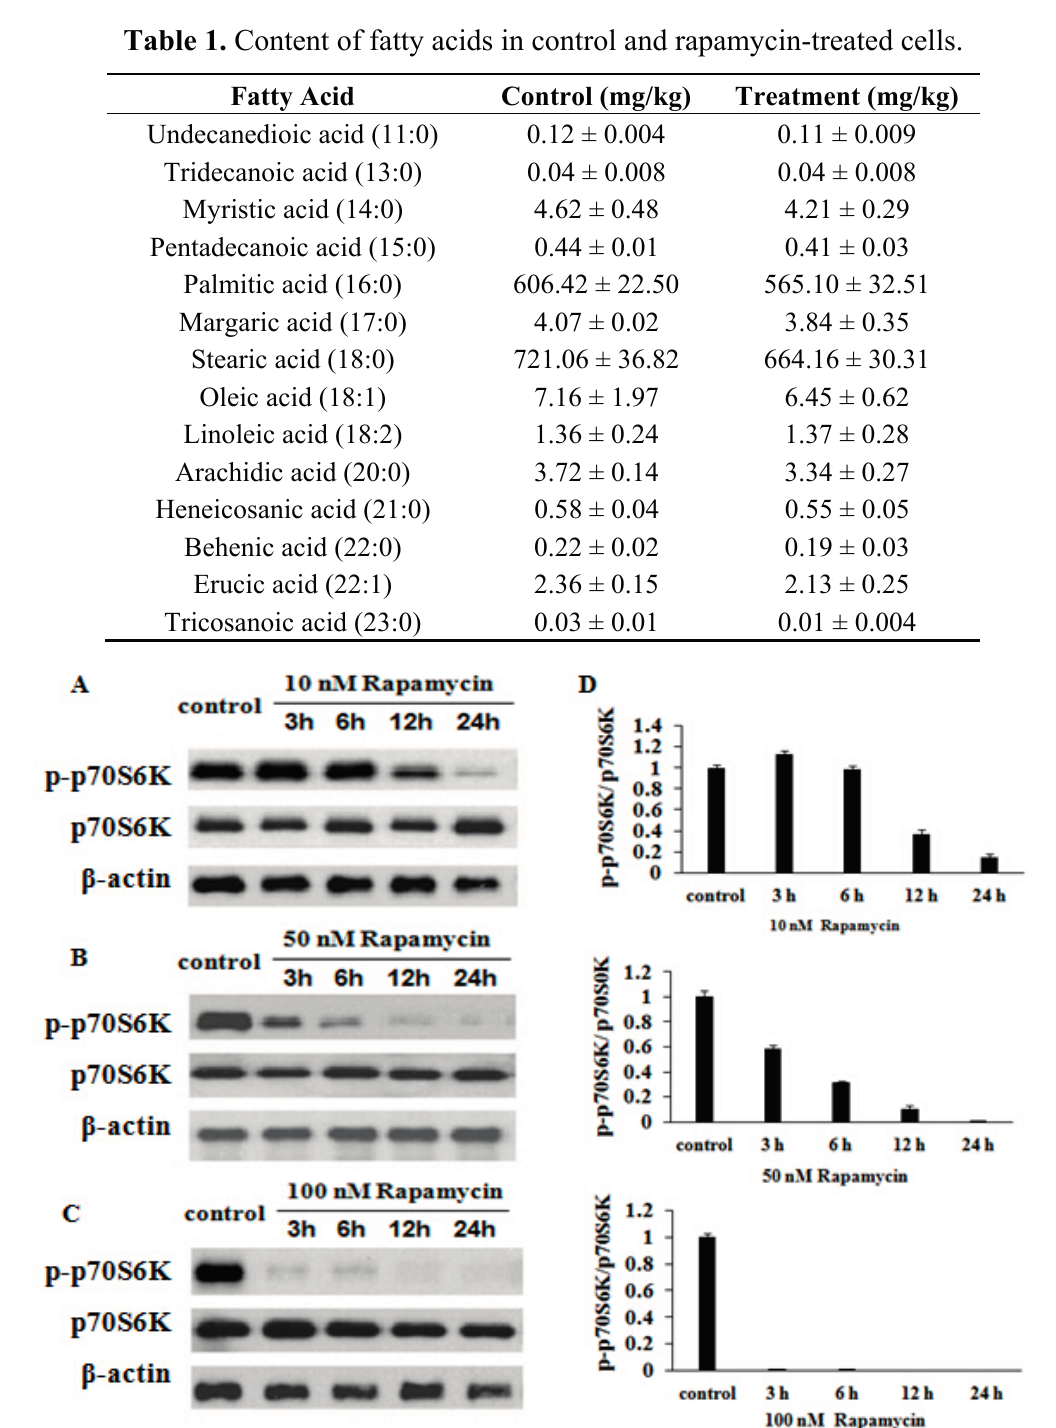
Figure 7. Rapamycin downregulates p70S6K (Thr 389) in GFb cells. Cells were treated with 10, 50 and 100 nM rapamycin for 3, 6, 12 and 24 h, and the expression of p70S6K, and p70S6K (Thr 389) were measured by Western blot. ( A ) Treatment with 10 nM. Phosphorylation of p70S6K (Thr 389) decreased after treatment for 12 h; ( B ) Treatment with 50 nM. Phosphorylation of p70S6K (Thr 389) was suppressed after 3 h; ( C ) Treatment with 100 nM. Phosphorylation of p70S6K (Thr 389) fell significantly after treatment for 3 h; ( D ) The resolved bands were quanti fi ed using Gel-Pro Analyzer 4.0 (Media Cybernetics, Inc., Rockville, MD,